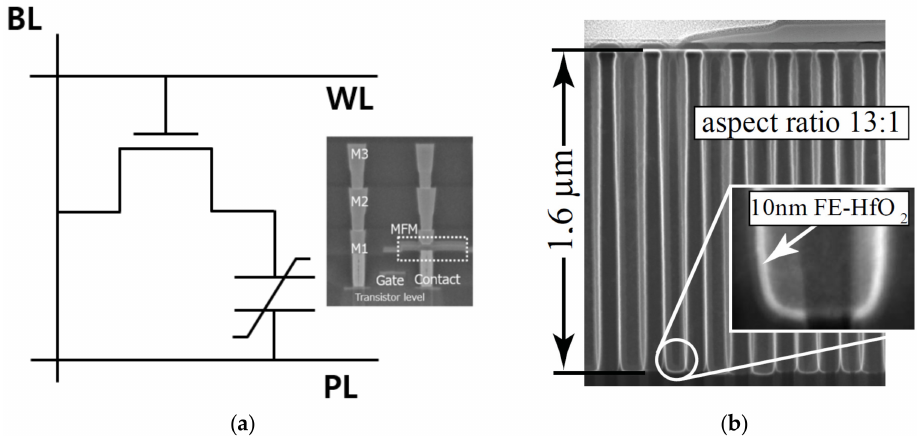
Figure 11. ( a ) Schematic of a 1T-1F FeRAM and cross section SEM image of an MFM capacitor integrated by BEOL process. Reproduced with permission [3]. Copyright 2020, IEEE. ( b ) ferroelectric HfO 2 based high aspect ratio 3D 1T-1C FeRAM. Reproduced with permission [99]. Copyright 2013,